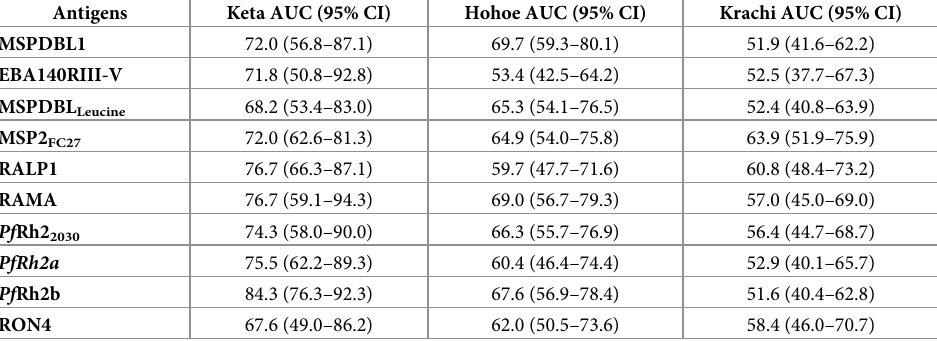
Table 2. Area under the curve (AUC) following receiver operating characteristics (ROC) analysis using antigens a predictor of